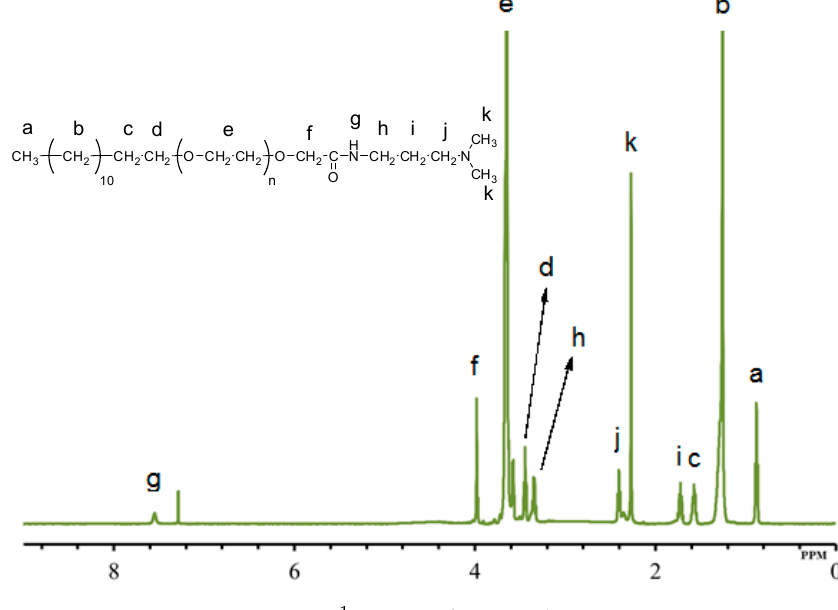
Figure 2. 1 H NMR of quaternary ammonium gemini surfactants (GS12). Table 1. 1 H NMR data exhibiting description of proton-type in GS12 [33–37]. Gemini Surfactants